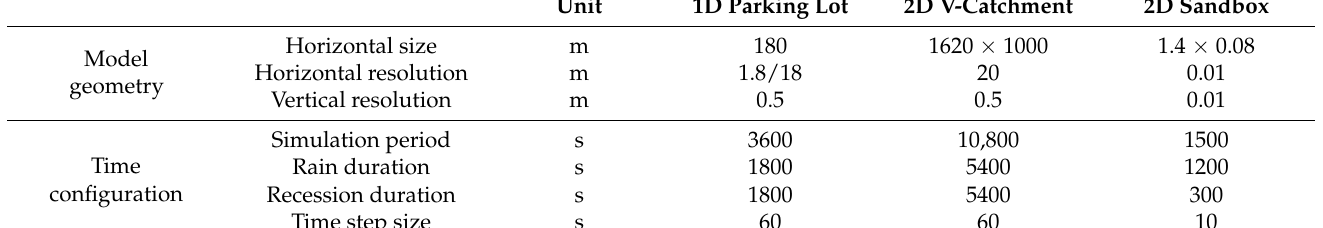
Table 3. Parameters in the 1D parking lot case and 2D tilted V-catchment case. Unit 2D